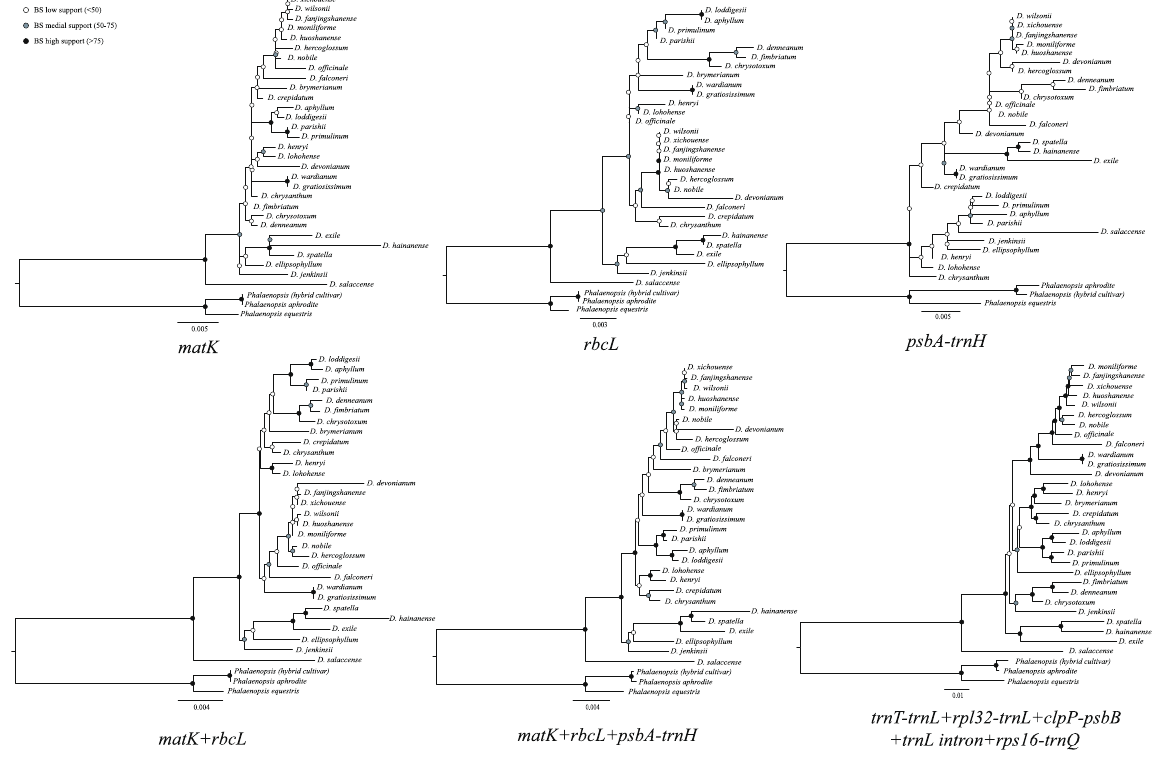
Figure 4. Maximum likelihood trees based on different plastid DNA